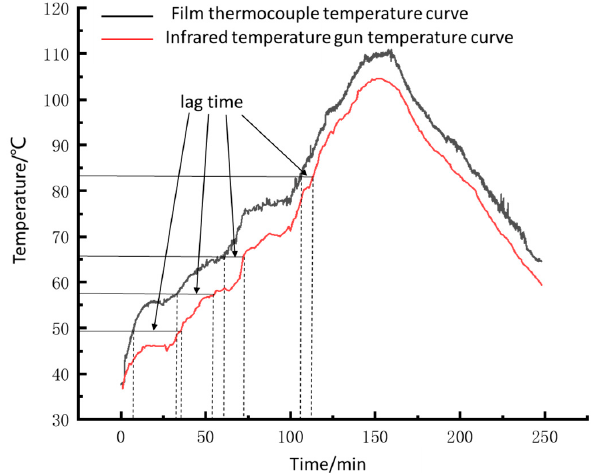
Figure 17. The dynamic curve of bearing temperature.